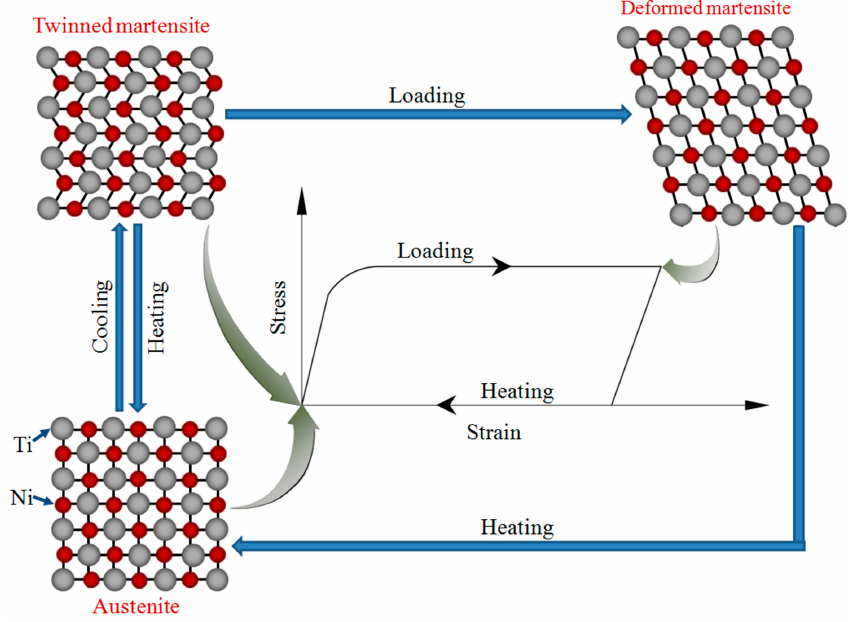
Figure 9. Schematic diagram of crystal structure evolution of NiTi SMA tube subjected to martensite reorientation and detwinning.